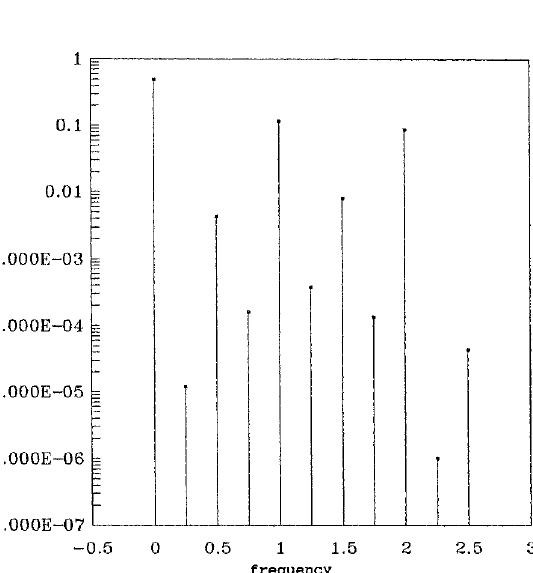
Fig. 7b. Spectrum q = 0 : 287359.